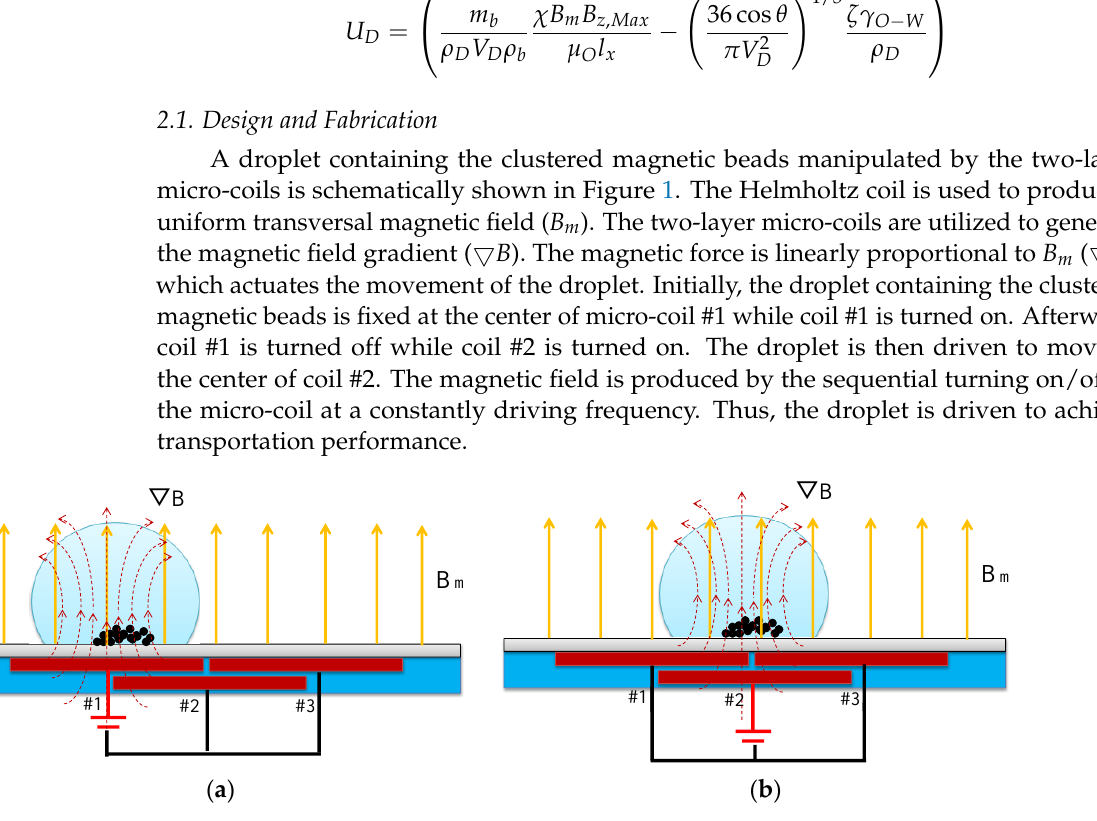
Figure 1. Schematic of the working principle of the two-layer micro-coil chip magnetically actuated droplet movement. ( a ) Fixed at the center of coil #1 while coil #1 is turned on. ( b ) Moved to the center of coil #2 while coil #2 is turned on and coil #1 is turned off.